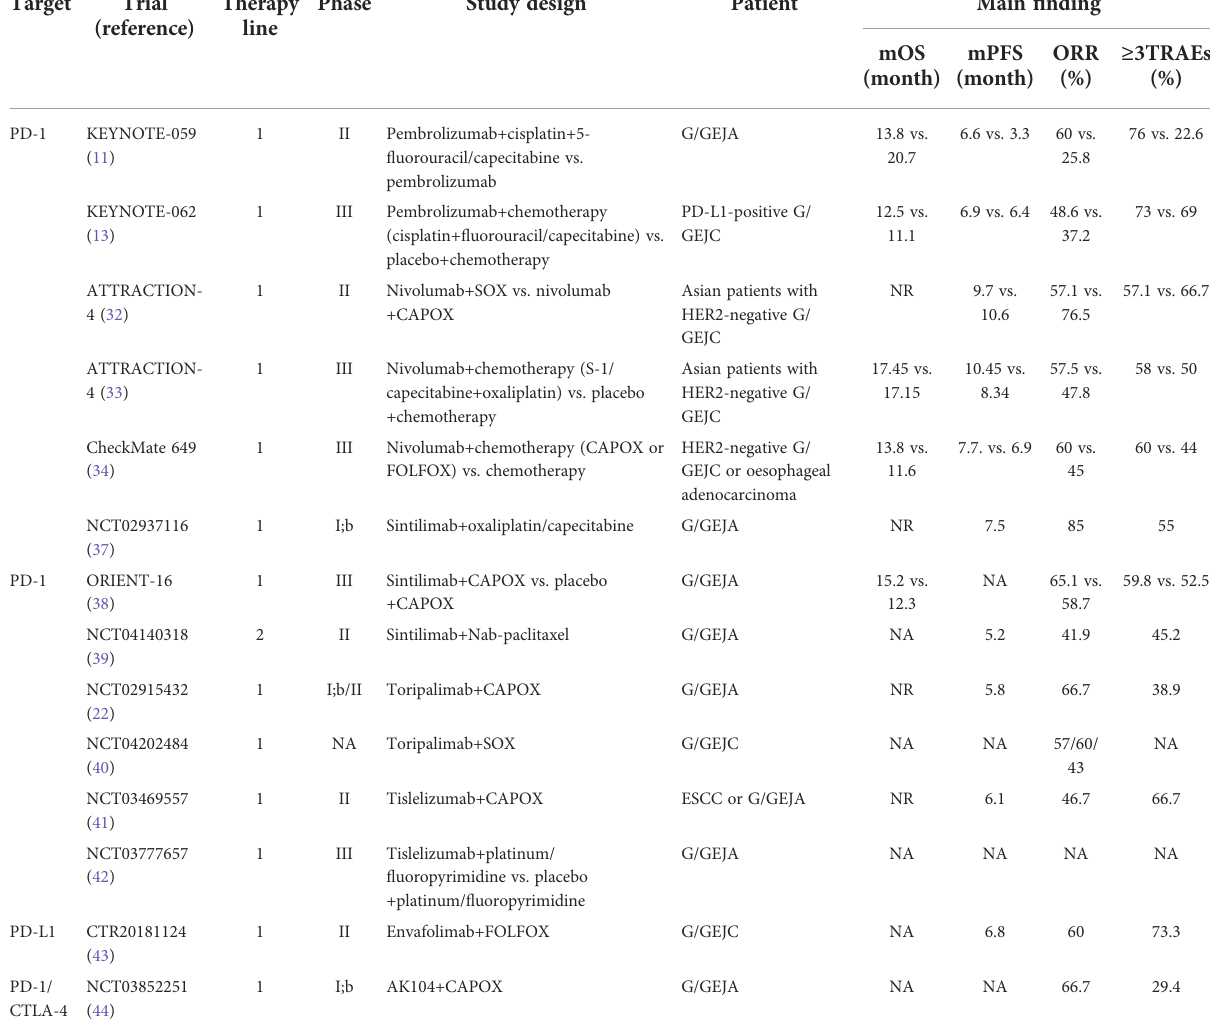
TABLE 2 Clinical trials of immune checkpoint inhibitors combined with chemotherapy in the treatment of advanced gastric cancer. Target Trial